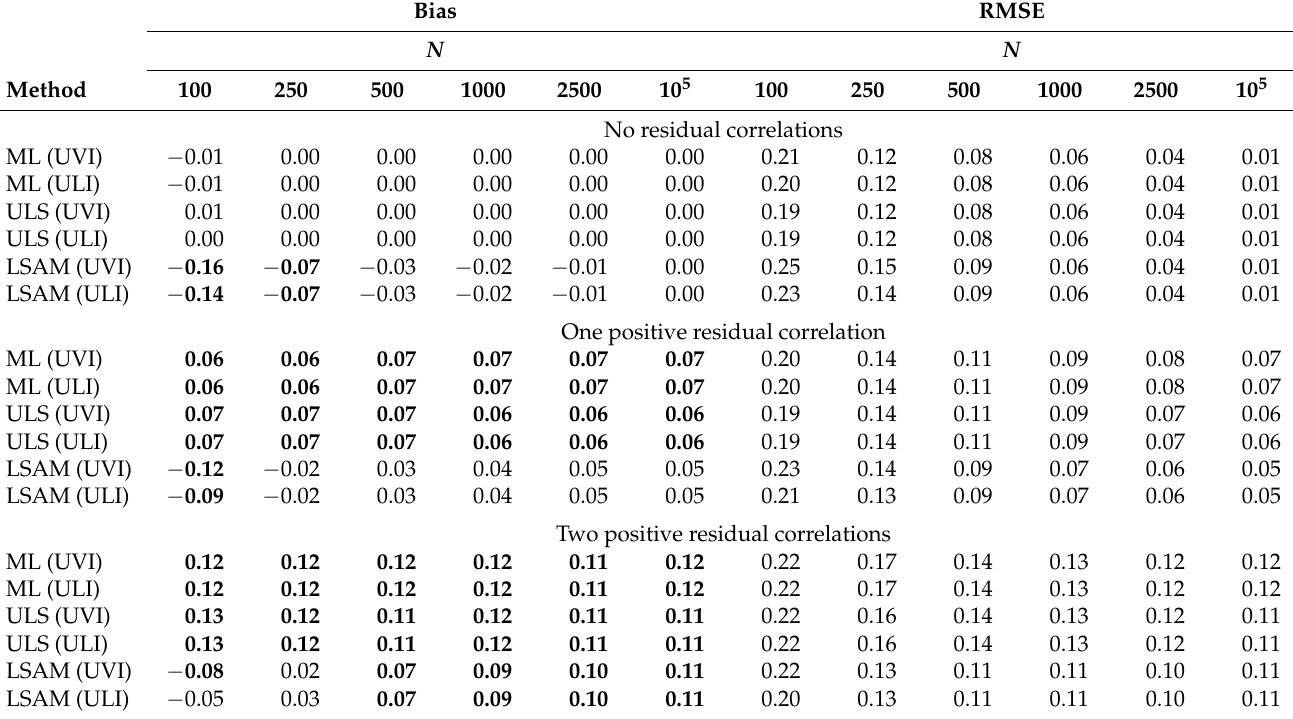
Table 3. Focused Simulation Study 1A (two factors and residual correlations): bias and root mean square error (RMSE) of estimated factor correlation as a function of sample size with one positive and two positive residual correlations in the data-generating model. for the unit latent variance (UVI) and unit loading identification (ULI).